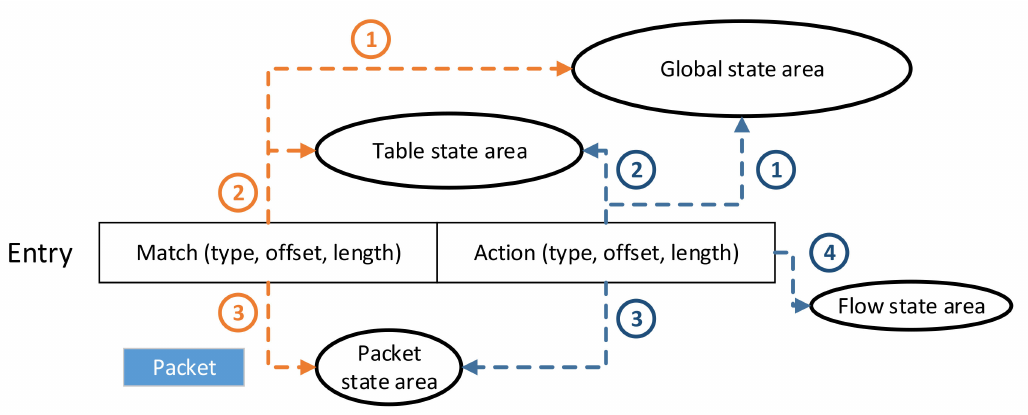
Figure 7. After the packet matches the entry, the state will only be in the three state areas if it is a matching field, and the state will only be in the four state areas if it is an instruction parameter.